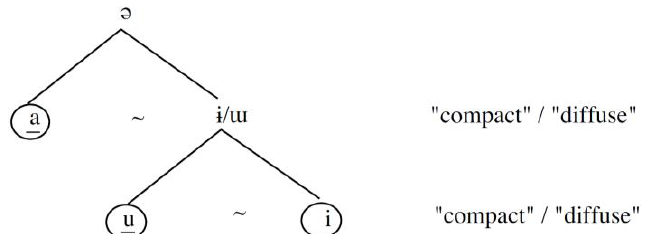
Figure 4 . Vowels resulting from the reiteration of the opposition ‘compact’ (marked) / ‘diffuse’ (unmarked), where primitive vowels are circled, and the marked term of which is underlined